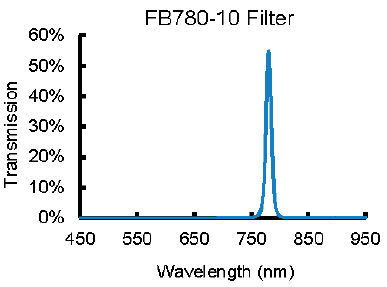
Figure 1. Transmission of the 780 nm bandpass